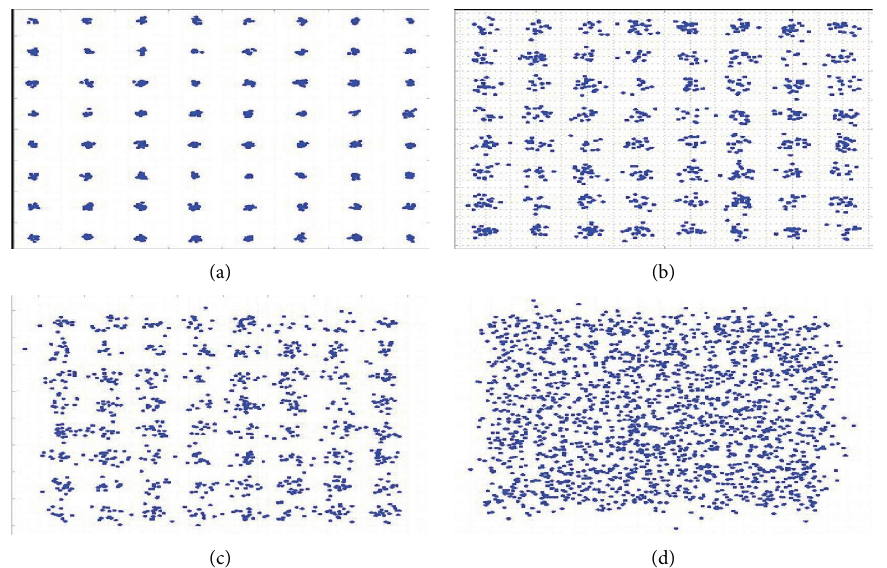
Figure 9: Constellation diagram estimations. (a) Te position of the 64QAM-OFDM signals at input side. (b) Te performance of the 5G NR-basedfber-FSO system at 150GHz/22Gbps at 25 km SMF. (c) Te outcomes achievements of the 5G NR-basedfber-FSO system at 200GHz/22Gbps and 25 km SMF. (d) Te performance of the convectional fber-FSO system at 25km SMF and